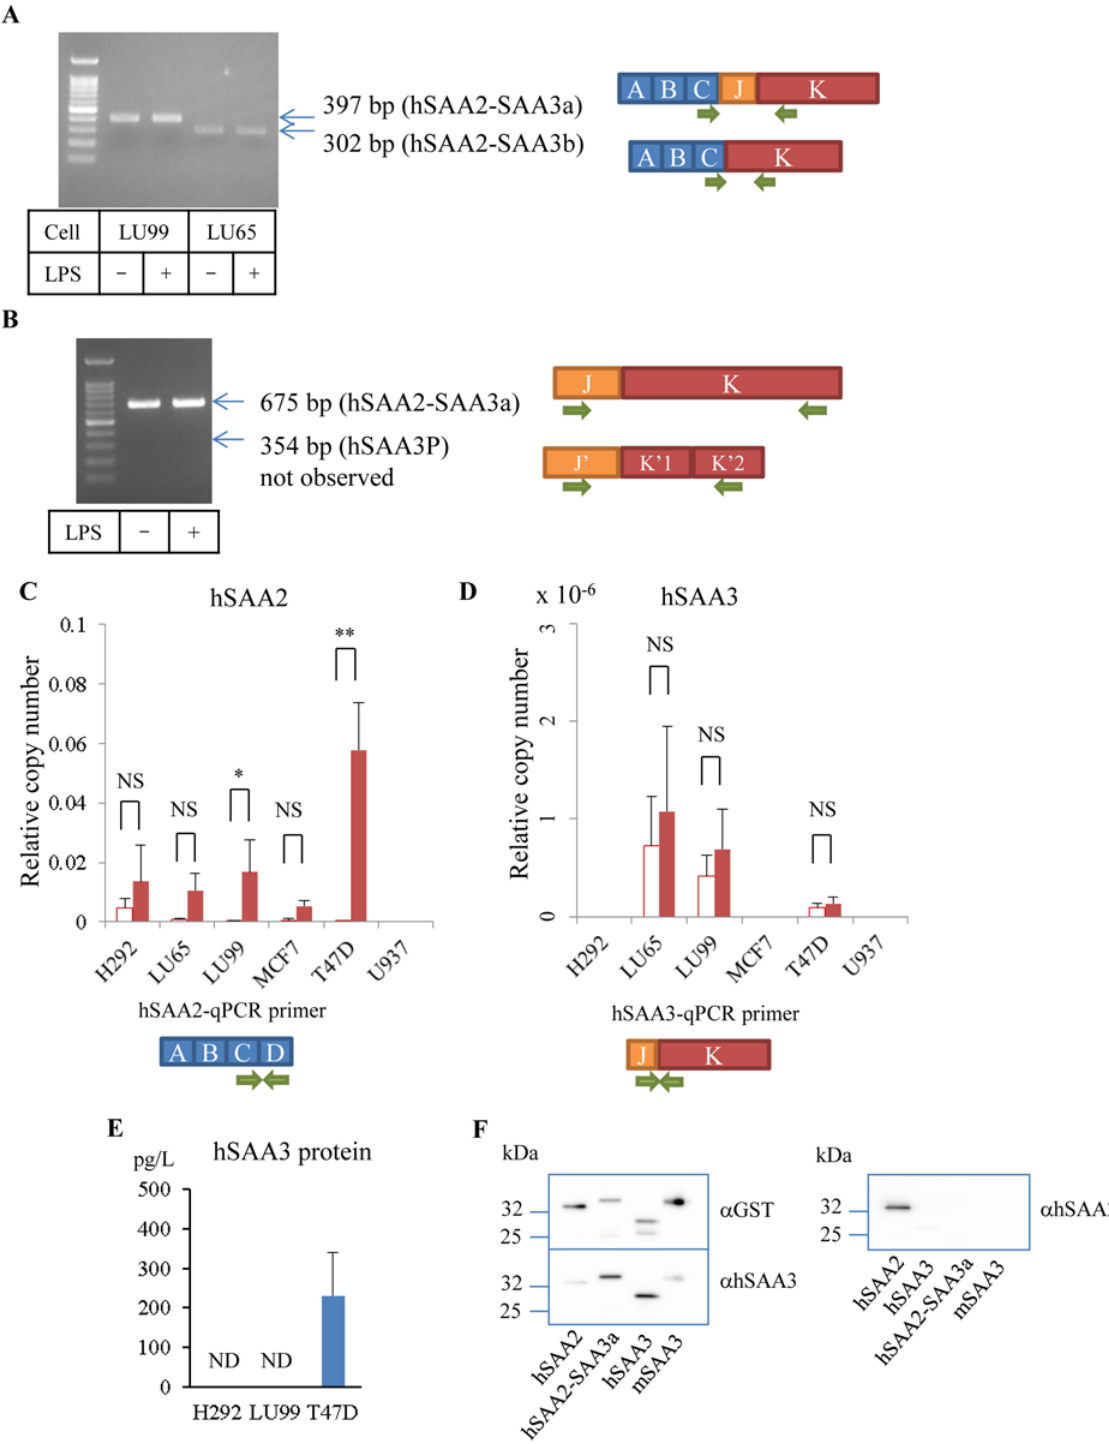
Fig 2. PCR detection of hSAA2-SAA3 readthroughs. (A) PCR with the hSAA2-SAA3-specific primer set. (B) PCR with the hSAA3-specific primer set. Complimentary DNAs were synthesized using a gene-specific primer that binds hSAA3 exon 2. The PCR products were subjected to DNA sequencing analyses to confirm that these bands were hSAA2-SAA3 readthrough origin (three independent experiments). (C) hSAA2 expression levels normalized to β -actin. * P = 0.0096, ** P = 0.0001. (D) hSAA3 expression levels normalized to β -actin. Open bars and filled bars represent without/with IL-1 β -IL-6- dexamethazone stimulation, respectively (four independent experiments). NS = not significant (P > 0.05). (E) hSAA3 concentrations determined by